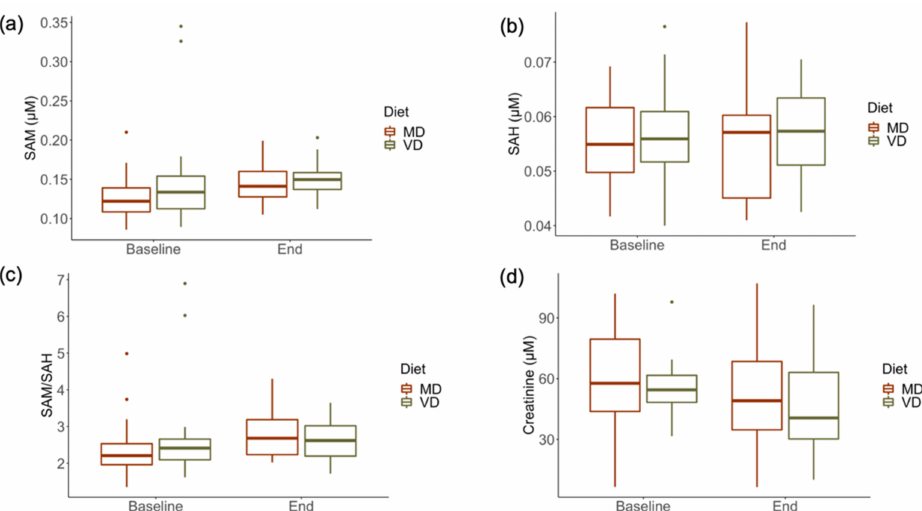
Figure 6. Plasma concentrations of SAM, SAH, the SAM:SAH ratio (SAM/SAH), and creatinine in an RCT with a 4 week intervention with vegan (VD) and meat-rich (MD) diets. ( a ) Plasma SAM at baseline and at the end of the trial. ( b ) Plasma SAH at baseline and at the end of the trial. ( c ) Ratio of plasma SAM and SAH at baseline and the end of the trial. ( d ) Plasma creatinine at baseline and at the end of the trial. Box plots show the median values (lines within the boxes) and the whiskers represent 1.5 interquartile ranges. Values that are classified as outliers are also